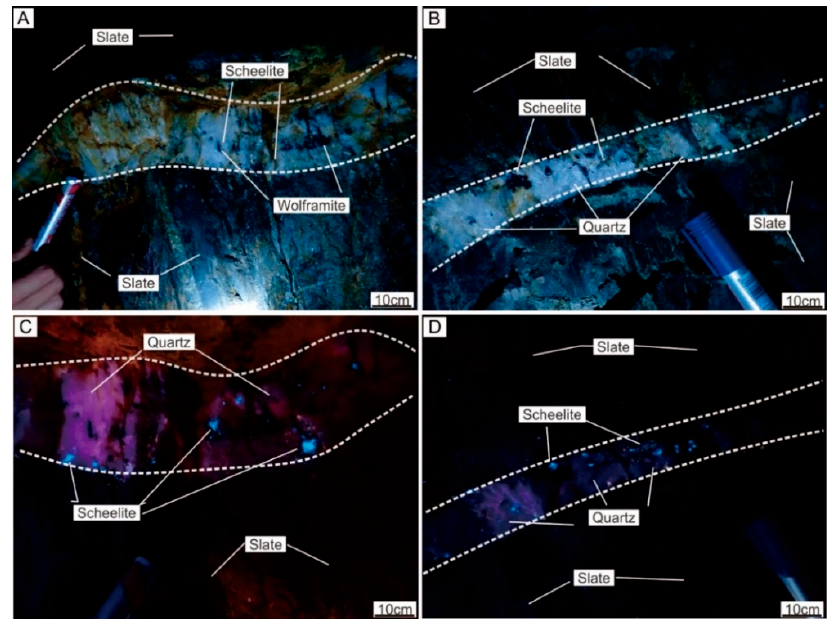
Figure 3. Outcrop photo of quartz-scheelite veins and disseminated scheelite in the tunnel at the Chuankou tungsten deposit; ( A , B ) show the occurrence of quartz-scheelite veins; ( C , D ) scheelite under a hand pick UV light, showing occurrence of scheelite in the same veins as ( A , B ).